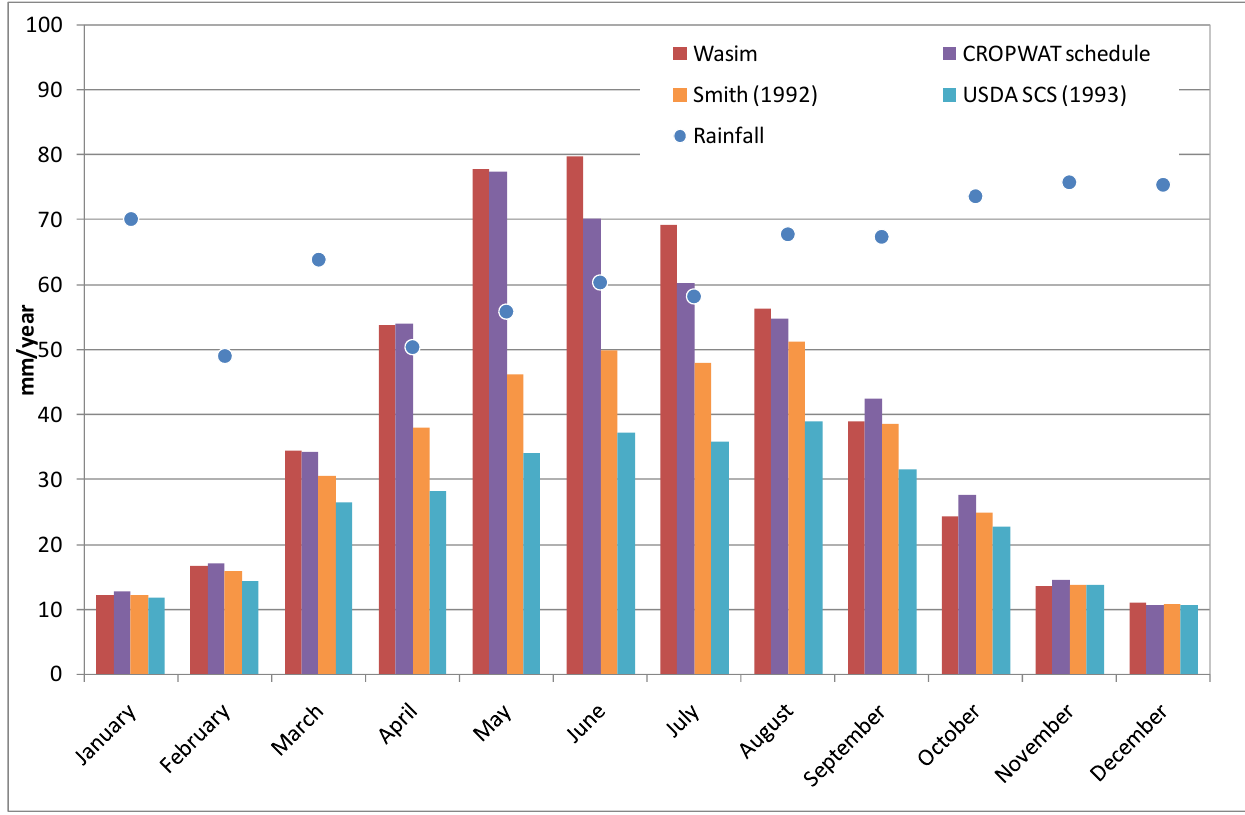
Figure 4. Average monthly evapotranspiration, ET method compared to average rainfall